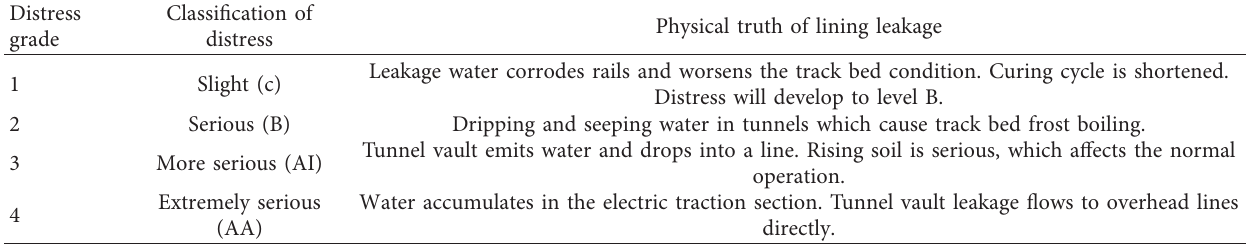
Table 10: Quantitative index of leakage distress in railway tunnels.